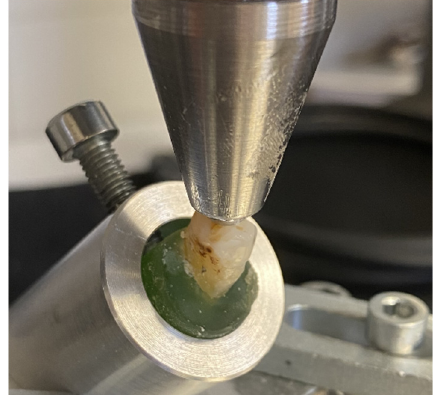
Figure 2. A photograph showing the test specimen and the fatigue load test setup.